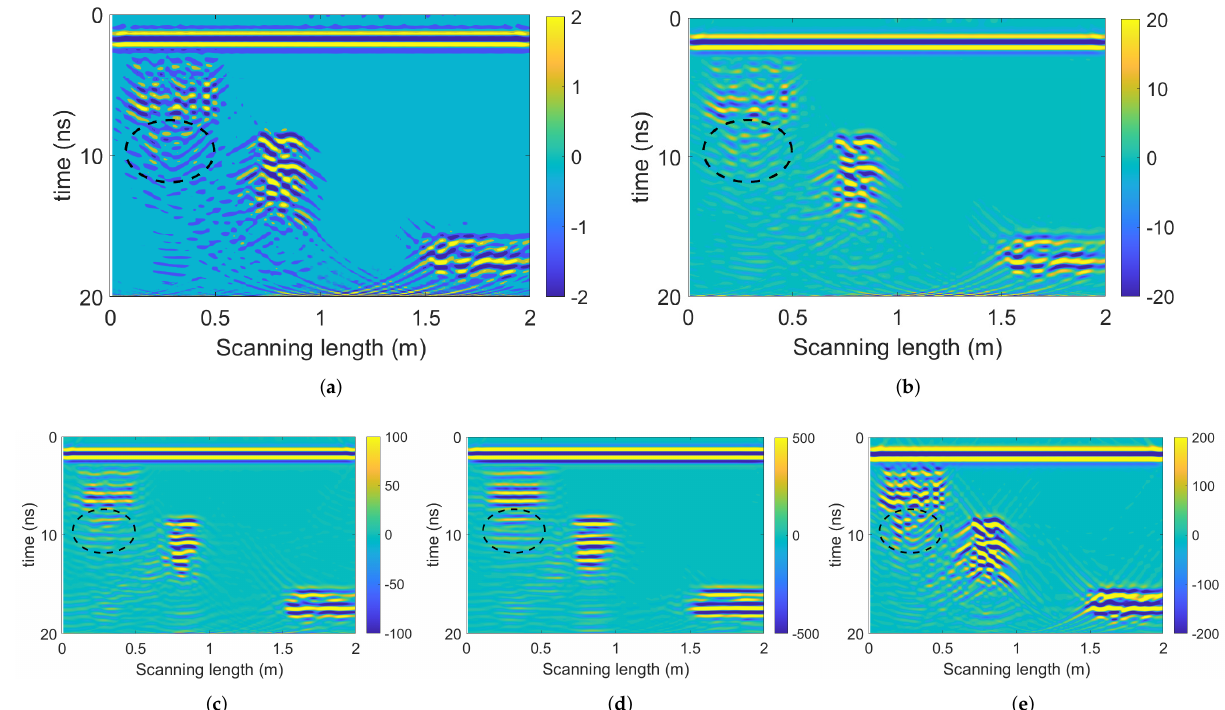
Figure 12. F-K migration results of ( a ) 1st-layer DH 1 , ( b ) 2nd-layer DH 2 , ( c ) 3rd-layer DH 3 , ( d ) 4th-layer DH 4 , and ( e ) pre-processed radargram without SWT decomposition.